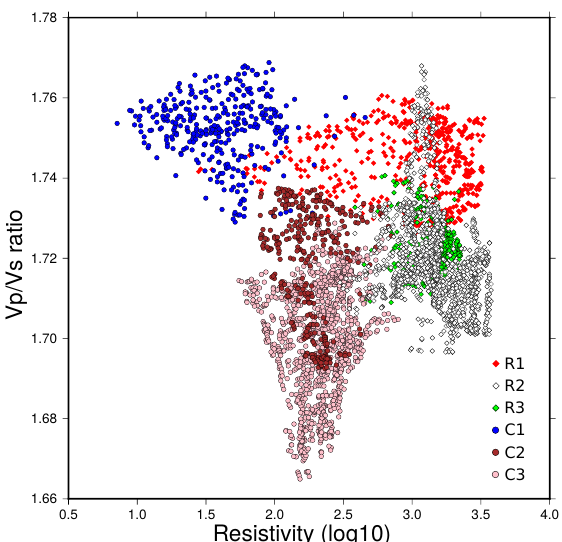
Figure 5. Vp/Vs ratio as a function of Log10 resistivity values for the northern profile. Each color refers to a body labelled in Figures 3 and 4. Diamonds represent the resistive structures and circles the conductives ones.